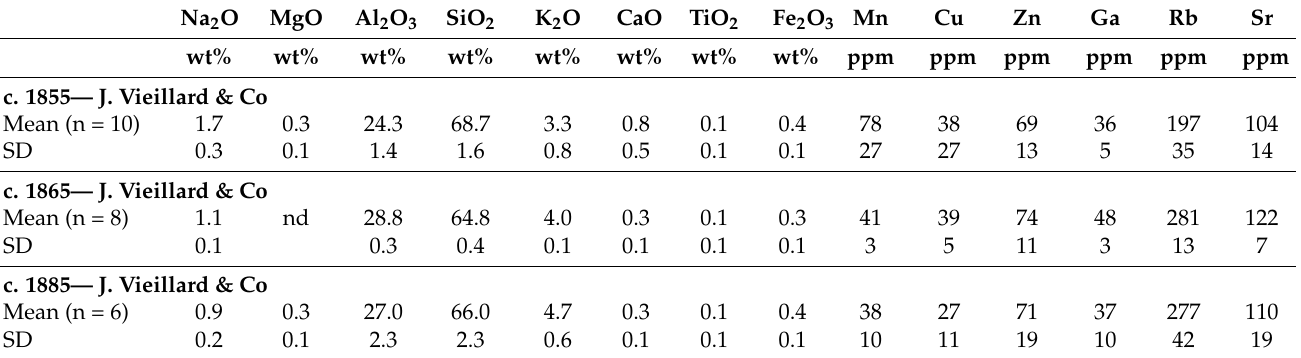
Table 4. The average chemical composition and standard deviation of the ceramic’s body, measured by PIXE analysis (wt% normalized to 100%). The data are the average over at least two analyses taken in different areas of the ceramic bodies. SD = standard deviation; nd = non